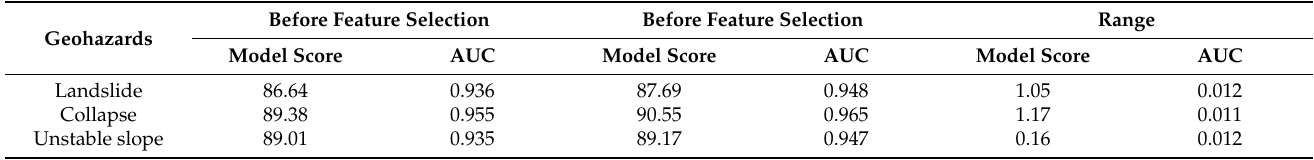
Table 7. Changes in model score and AUC after using filter-MDA feature selection method.